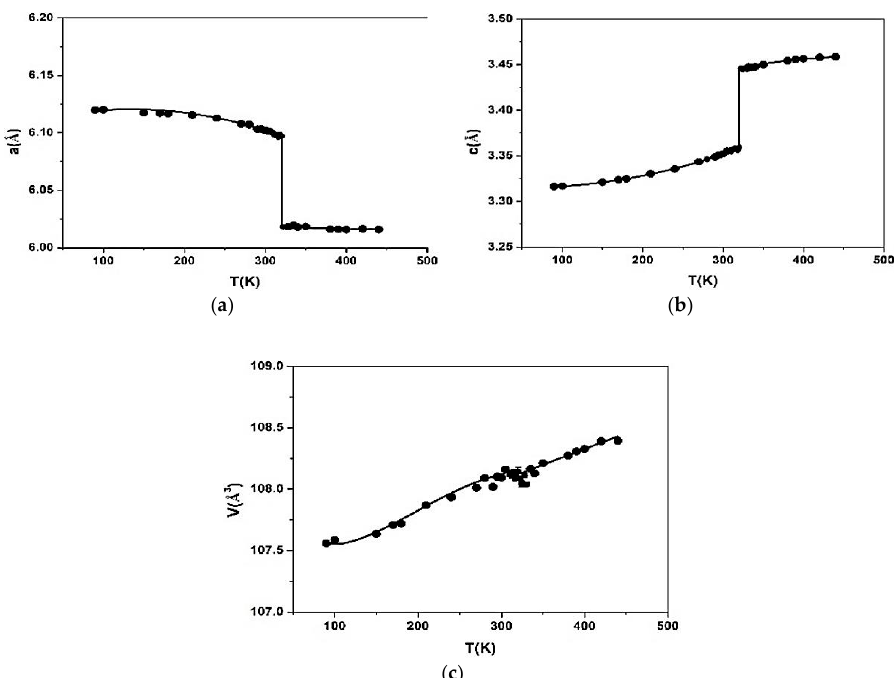
Figure 4. Thermal variation of the cell parameters for Mn 0.7 Fe 1.3 P 0.65 Si 0.35 : ( a ) a-cell parameter; ( b ) c-cell parameter; ( c ) cell volume.